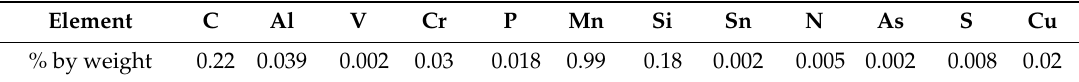
Table 1. Chemical composition of ASME SA 516 Grade 70.